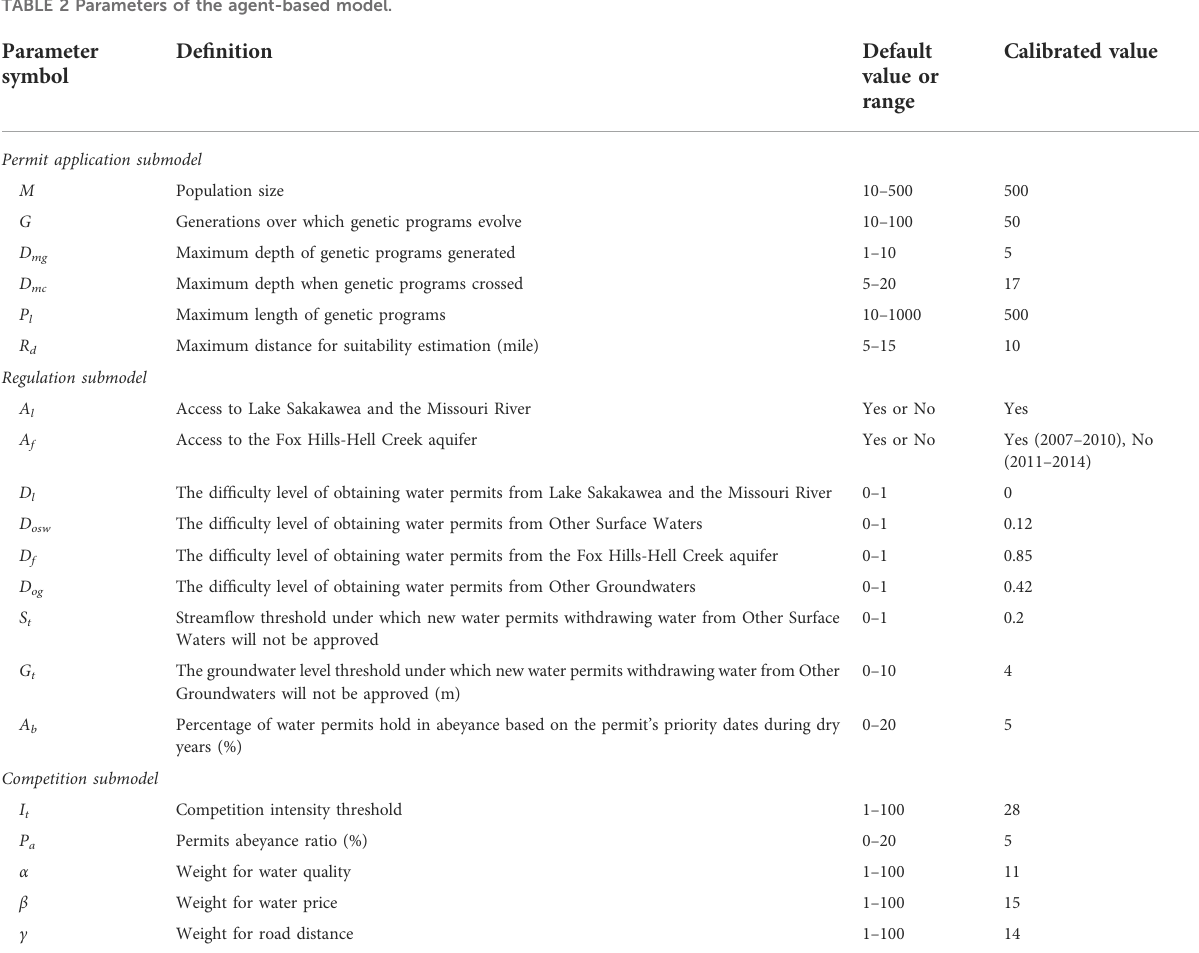
TABLE 2 Parameters of the agent-based